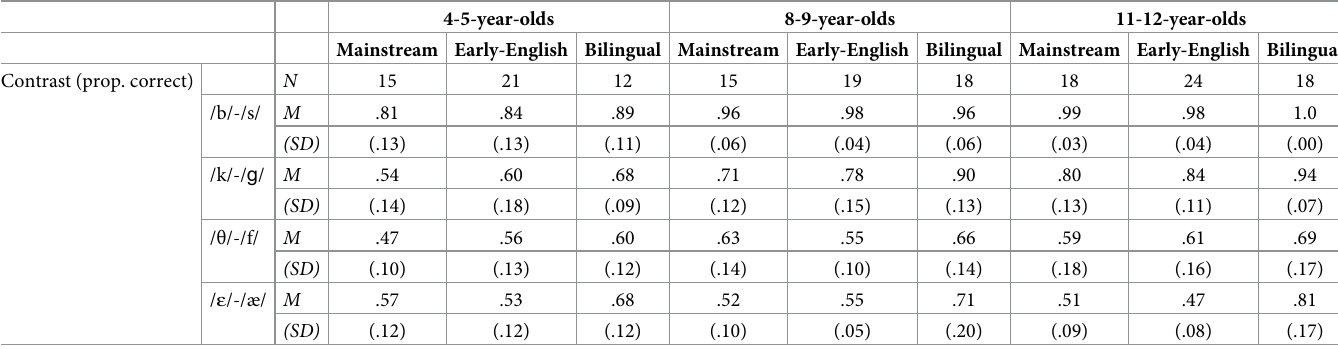
Table 1. Percentage correct on each of the contrasts, for each type of English acquisition